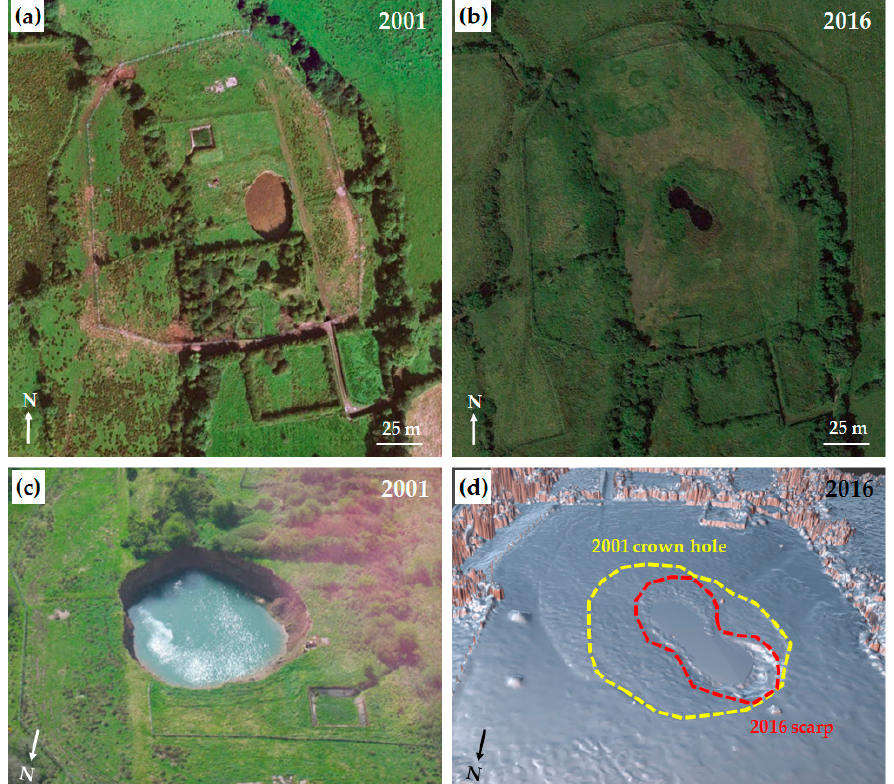
Figure 9. Satellite images of the area of the Maiden Mount salt mine collapse at Carrickfergus from Google Earth on ( a ) 31 December 2001 © 2017 The GeoInformation Group and ( b ) 16 August 2016 © 2016 Google; ( c ) aerial view of the 2001 crown hole collapse © Crown Copyright; and ( d ) shaded relief of the VHR Digital Surface Model (DSM) with indication of the 2001 crown hole and a more recent scarp formed in the filling material.